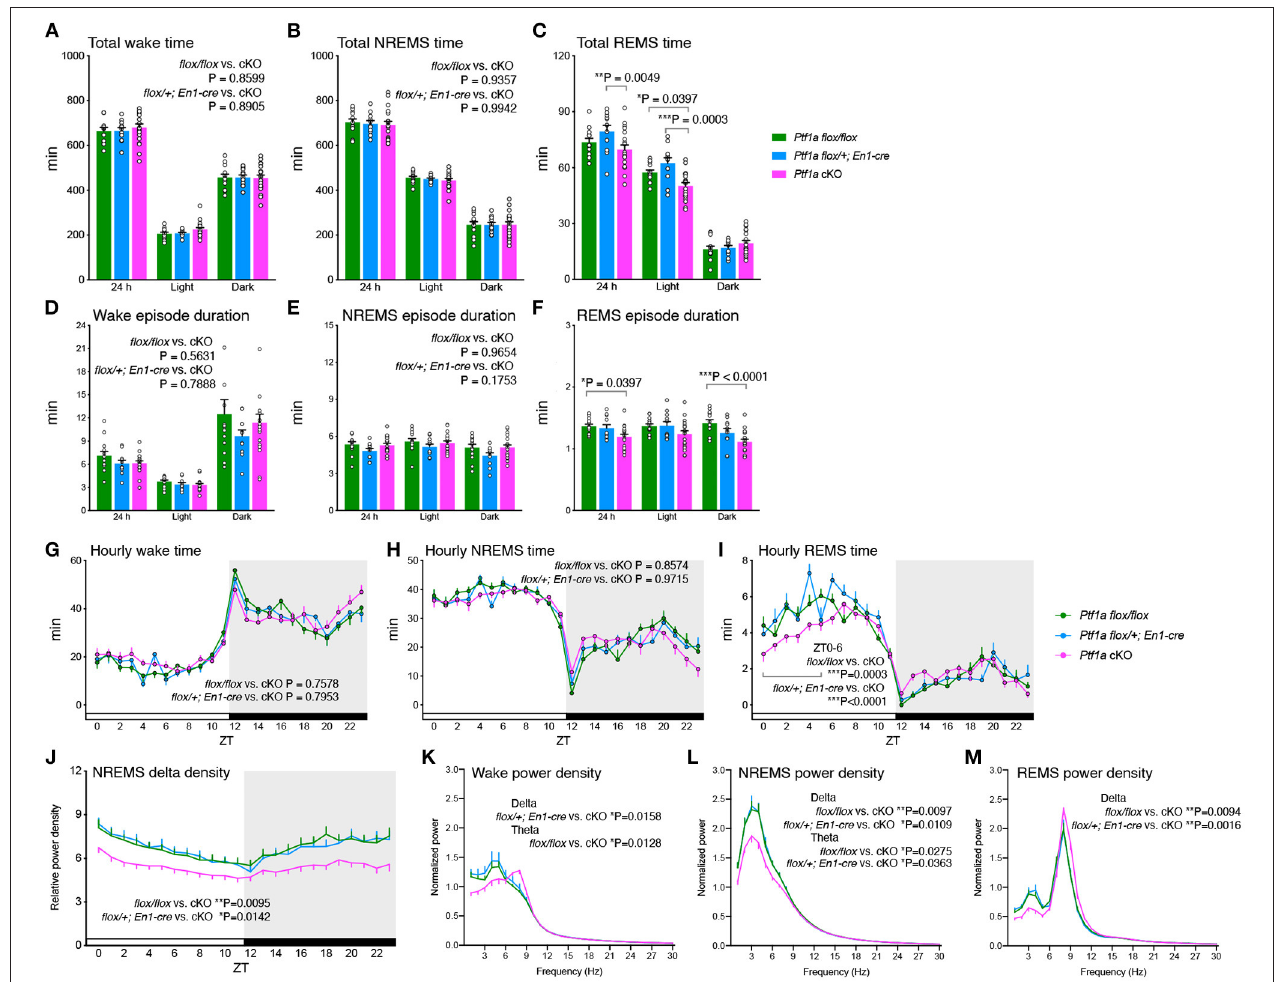
FIGURE 2 | Sleep/wake behavior of adult male Ptf1a cKO mice. (A–C) Time spent in wake (A) , NREMS (B) , and REMS (C) of Ptf1a cKO and control mice over 24h and during the light and dark phases. Two-way ANOVA with Sidak’s multiple comparisons test. (D–F) Episode duration of wake (D) , NREMS (E) , and REMS (F) of Ptf1a cKO and control mice. Two-way ANOVA with Sidak’s multiple comparisons test. (G–I) Daily variations in wake (G) , NREMS (H) , and REMS (I) . Mixed-effects analysis followed by Tukey’s test for the hourly time in early light phases (ZT0-6). (J) Hourly NREMS delta power density over 24h. Mixed-effects analysis followed by Sidak’s test. (K–M) EEG power spectra of Ptf1a cKO and control mice during wake (K) , NREMS (L) , and REMS (M) . Mixed-effects analysis followed by Sidak’s test for the delta- and theta-ranges. n = 13 for Ptf1a flox / flox , n = 11 for En1 cre / + ; Ptf1a flox / + , n = 19 for En1 cre / + ; Ptf1a flox / flox . Data are the mean ± S.E.M. * P < 0.05. ** P < 0.01. *** P <